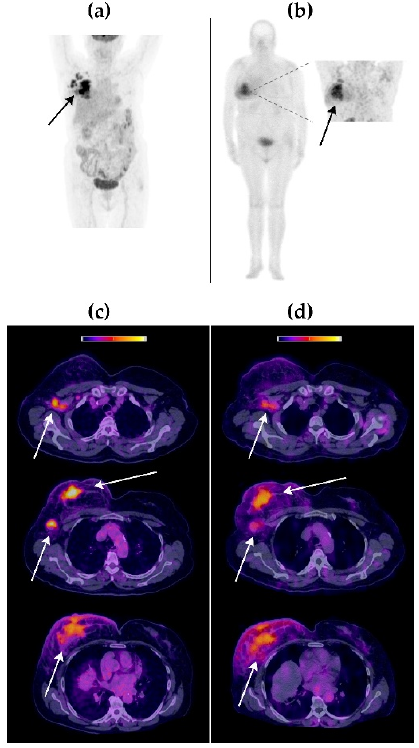
Figure 3. Patient with triple-negative right breast cancer (Patient 1). ( a ) Maximum-intensity projection [ 18 F]FDG PET image at 1 h p.i. ( b ) [ 99m Tc]Tc-iFAP whole-body planar scintigraphy in anterior projection. Inset: thoracic SPECT at 3 h p.i. ( c ) [ 18 F]FDG PET/CT axial sections. ( d ) [ 99m Tc]Tc ‐ iFAP SPECT/CT axial sections. Right mammary gland with increased size and thickening of the generalized cutaneous plane, with a solid lesion as well as poorly defined borders in the interline topogra ‐ phy of the upper quadrants that extends to the retroareolar region, conditioning its retraction